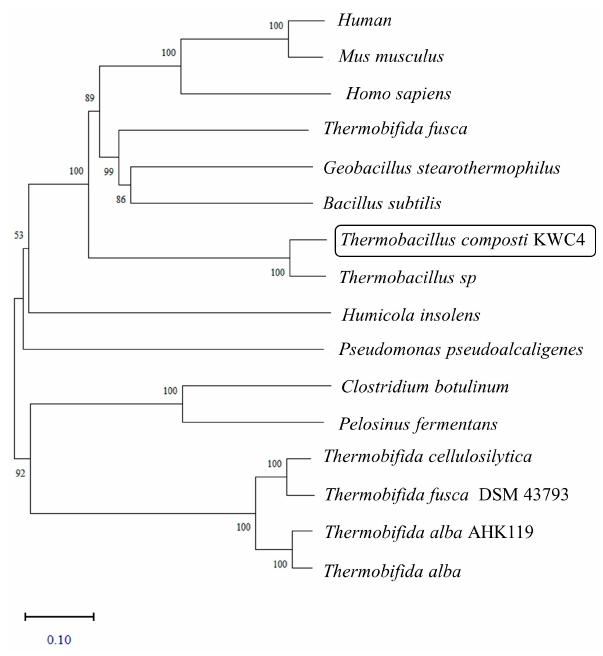
Figure 1. Phylogenetic dendrogram of Tcca from Thermobacillus composti KWC4 and its homologues. The phylogenetic tree was constructed by neighbor–joining method, evolutionary analyses were conducted with MEGA11, and the box is Tcca. Carboxylesterase: Thermobacillus composti KWC4 (Tcca), WP_015255658.1; Thermobacillus sp, REK52384.1; Thermobifida fusca (TfCa), WP_104613014.1; Geobacillus stearothermophilus (Est55), PDB: 2OGS. Esterase: Bacillus subtilis , PDB : 1QE3; Pseudomonas pseudoalcaligenes (PpEst), WP_003460012; Clostridium botulinum (EstA), PDB: 5AH1; Thermbifida fusca DSM 43793 (TfH), CAH17554.1. Cutinase: Humicola insolens (Hic), PDB: 4OYL; Thermobifida cellulosi- lytica (Thc cut1), PDB: 5LUI; Thermobifida alba AHK119 (Est119), PDB: 3VIS; Thermobifida alba (Est1), D4Q9N1.2. Lipase: Pelosinus fermentans (PfL1), EIW29778.1. Acetylcholinesterase: Human , PDB: 4BDT; Mus musculus , PDB: 2C0P. Butyrylcholinesterase: Homo sapiens , PDB: 6EMI. Carboxylesterases possess a common catalytic triad consisting of a nucleophile (ser- ine, aspartate, or cysteine), a histidine, and a catalytic acid (aspartate or glutamate) [30]. The serine residue of the catalytic triad is usually found in the pentapeptide G–X–S–X–G, on the nucleophile elbow; these protein share a similar structural fold to the α / β hydrolase superfamily [31]. Among Tcca homologous enzymes with available crystal structures, the following three share the highest protein sequence identities with Tcca: TfCa from Ther- mobifida fusca (PDB: 7W1K [32], 32% identity), Est55 from Geobacillus stearothermophilus (PDB: 2OGS [33], 31% identity) and p –nitrobenzyl esterase ( p NB–E) from Bacillus subtilis (PDB: 1QE3 [34], 30% identity). Protein sequence alignment of Tcca against TfCa, Est55 and p NB–E (Figure 2) indicates that Tcca contains a conserved catalytic triad consisting of S203, E324 and H414, in which S203 is located on the top of “nucleophile elbow” and